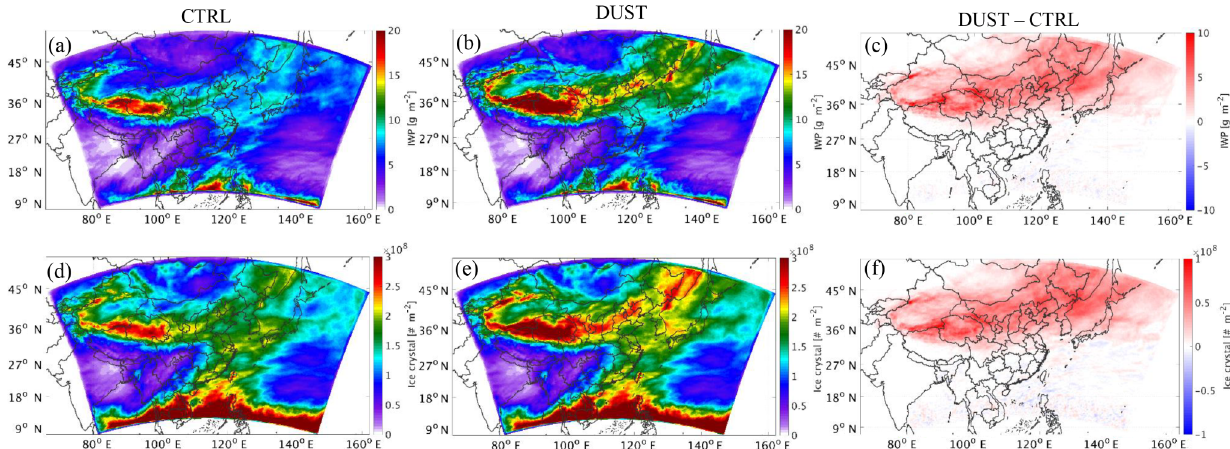
Figure 7. Spatial distributions for the temporal mean simulated cloud ice water path (a–c) and ice crystal number density (d–f) from CTRL (left column), DUST (middle column), and the difference between CTRL and DUST (right column) over East Asia (domain 1) during the simulation